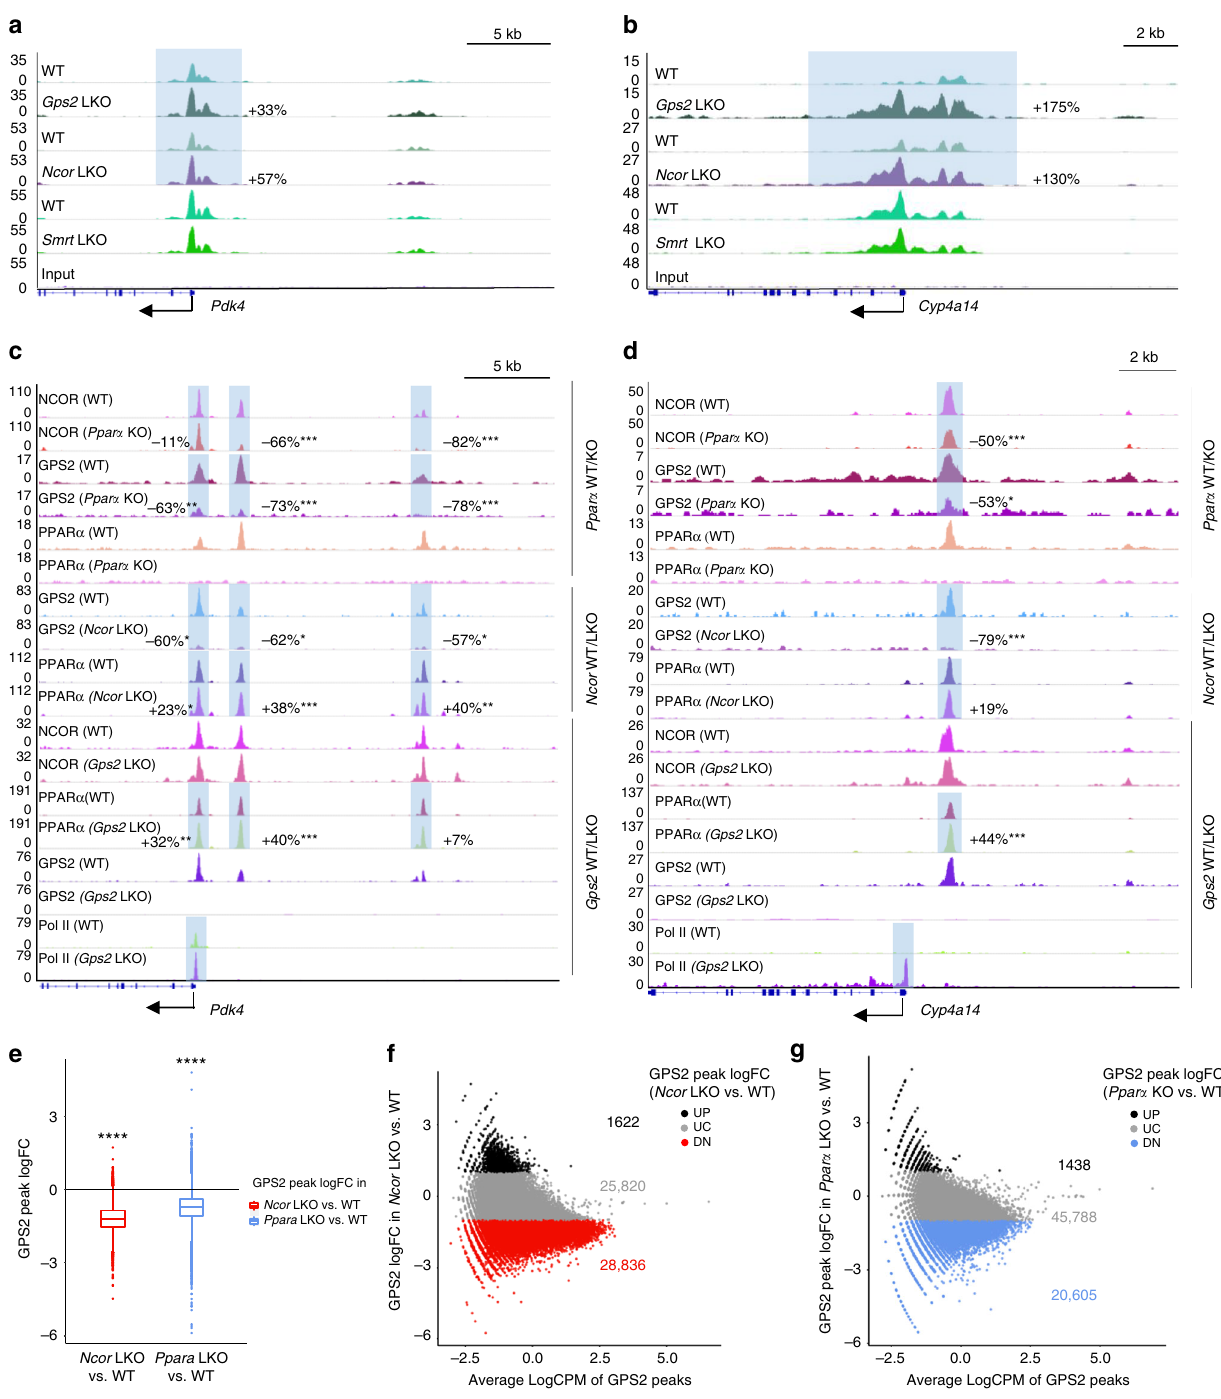
Fig. 5 GPS2 cooperates with NCOR to repress target gene expression. a , b ChIP-seq tracks representing H3K27ac at ( a ) Pdk4 and ( b ) Cyp4a14 loci in Gps2 , Ncor and Smrt LKO and respective WT mouse livers. Percentage of increase represents logFC of each peak and is calculated from biological duplicates (for Gps2 LKO versus WT) or triplicates (for Ncor or Smrt LKO versus WT). c , d ChIP-seq tracks representing NCOR, GPS2, PPAR α , and Pol II recruitment in Ppar α KO, Ncor LKO, Gps2 LKO and respective WT livers at ( c ) Pdk4 and ( d ) Cyp4a14 loci. Percentage of increase represents logFC of each peak and is calculated from biological triplicates. e Boxplot representing average logFC of co-localized GPS2 peaks in Ncor LKO and Ppar α KO versus WT livers ( n = 3 in each group). f , g MA plots showing the average logFC of GPS2 peaks between ( f ) Ncor LKO versus WT; and ( g ) Ppar α KO versus WT livers, against average logCPM. UP, UN, and DN represents upregulated, unchanged, and downregulated peaks, respectively. All data are represented as mean ± s.e.m. * P < 0.05, ** P < 0.01, *** P <